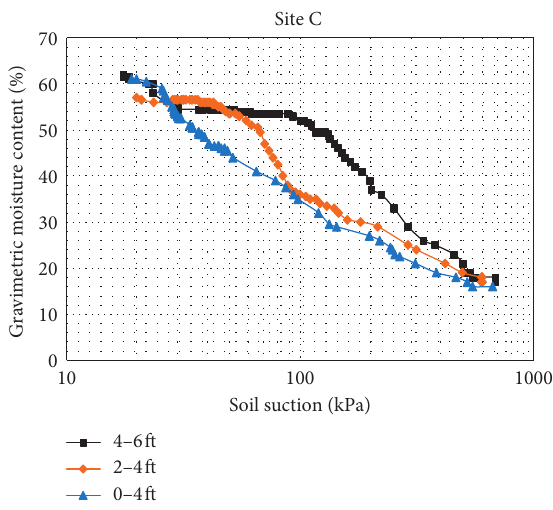
Figure 15: Soil-water characteristic curves (SWCC) for site C.